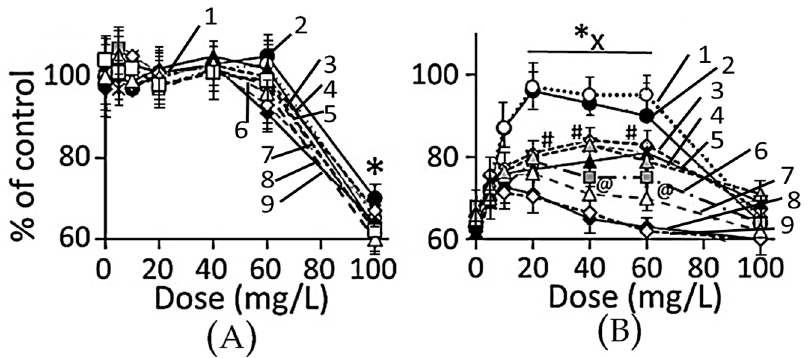
Figure 8. ( A ) Plots of dose (AuNP mg/L) versus viable Ap/En cells (% of control) at day 16. A 5 to 60 mg/L dose of all AuNP exhibited comparable response. Only 100 mg/L dose caused significant decrease in viable cell enumeration. Values are mean ± SD; ( B ) Plots of dose (AuNP mg/L) versus viable Ap/Ep cells (% of control) at day 16). Different AuNPs yielded variable response, but maximum protection was provided by AuNP KG-50,-90 at 20 mg/L dose. Values are mean ± SD. *: p < 0.05 when compared with An/En response and x, # or @: p < 0.05, when viability of Ap/Ep cells exposed to a given dose of and AuNP compared with viability of Ap/Ep exposed to the same dose of other AuNPs. 1: AuNP KG-90 , 2: AuNP KG-50 , 3: AuNP KG-50 , 4: AuNP KG-37 , 5: AuNP K-50,90 , 6: AuNP PEG +KG, 7: AuNP KG-37 , 8: AuNP PEG , 9: AuNP G-50,G90 .